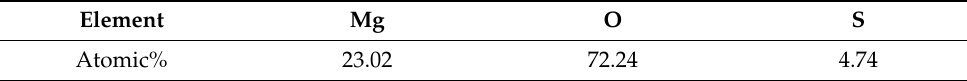
Figure 9. XPS profile of the products with 0.8 wt% CS ( a ), and high-resolution XPS profiles of O 1s ( b ), Mg 1s ( c ), and S 2p ( d ). Table 2. Elemental content of the products of 0.8 wt% CS analyzed using XPS.